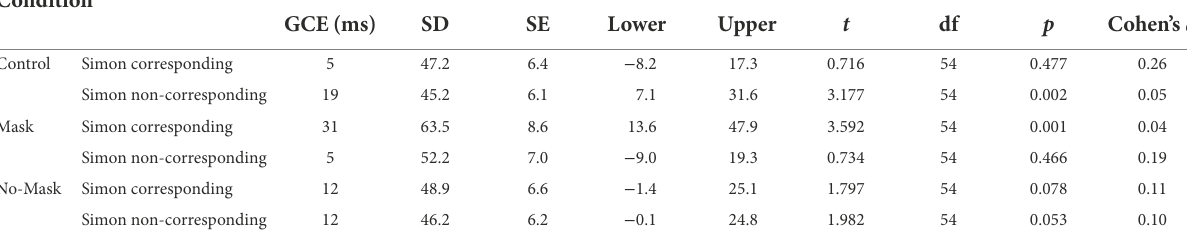
TABLE 1 Paired simple t-test comparing GCE effect (i.e., Incongruent vs. Congruent trials) in Simon Non-corresponding and Corresponding trials for each experimental condition (i.e., Control, Mask, No-Mask).